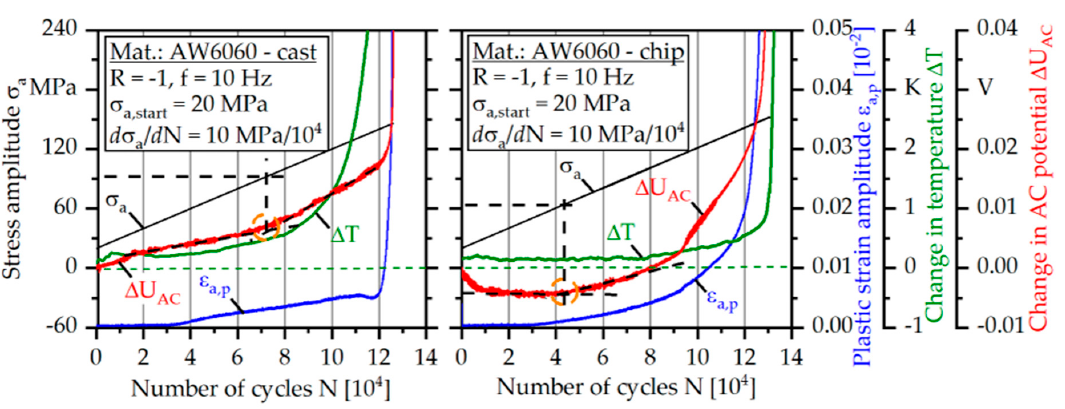
Figure 7. Load increase tests of cast-based and chip-based specimens.